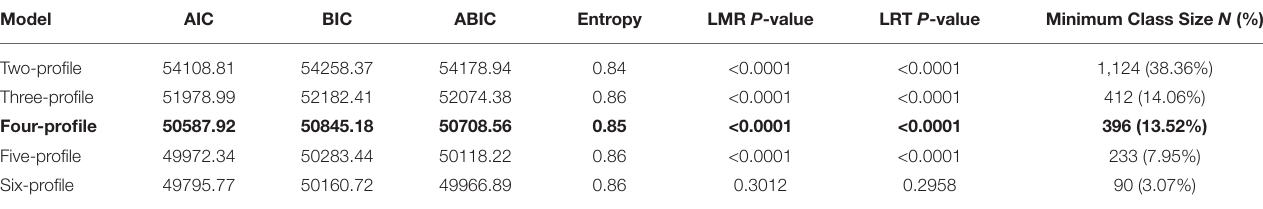
TABLE 2 | Model fit indexes of latent profile analysis ( N = 2,930).